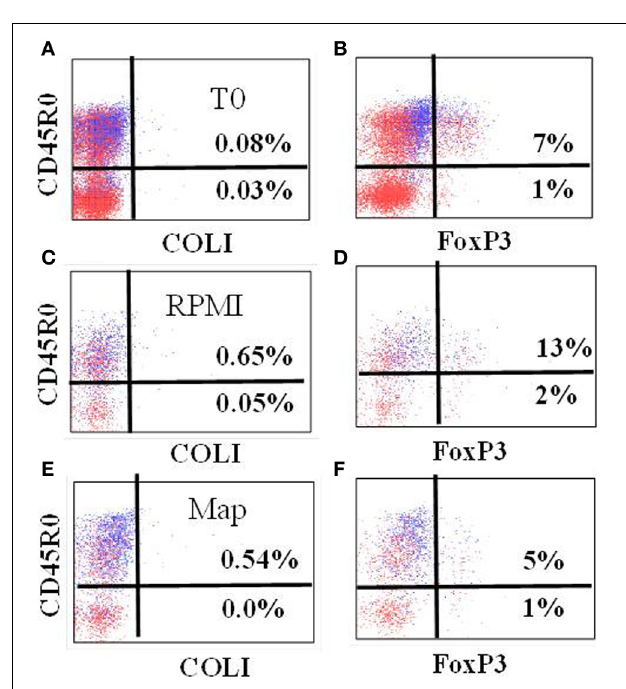
FIGURE 6 | Representative profiles showing expression of FoxP3 in gated CD4 T cells at T0 (A,B), and cultured in RPMI alone (C,D) and stimulated with live Map (E,F) from a calf of RelA group. As noted, use of anti-CD45R0 rather than anti-CD25 provides better resolution of cells expressing FoxP3. COLI = isotype